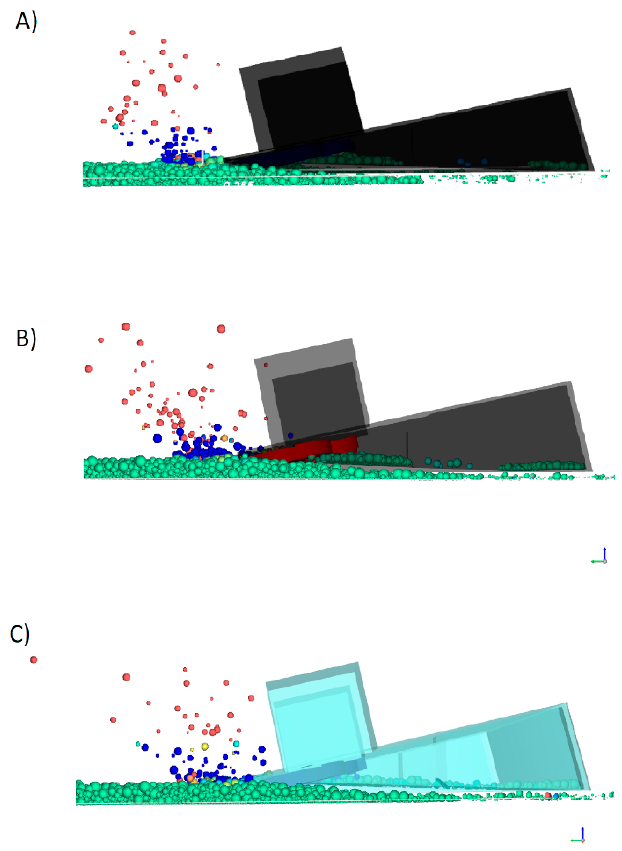
Figure 16. Particle “shots” for: ( A ) Earth gravity, ( B ) Mars gravity, ( C ) Moon gravity values.